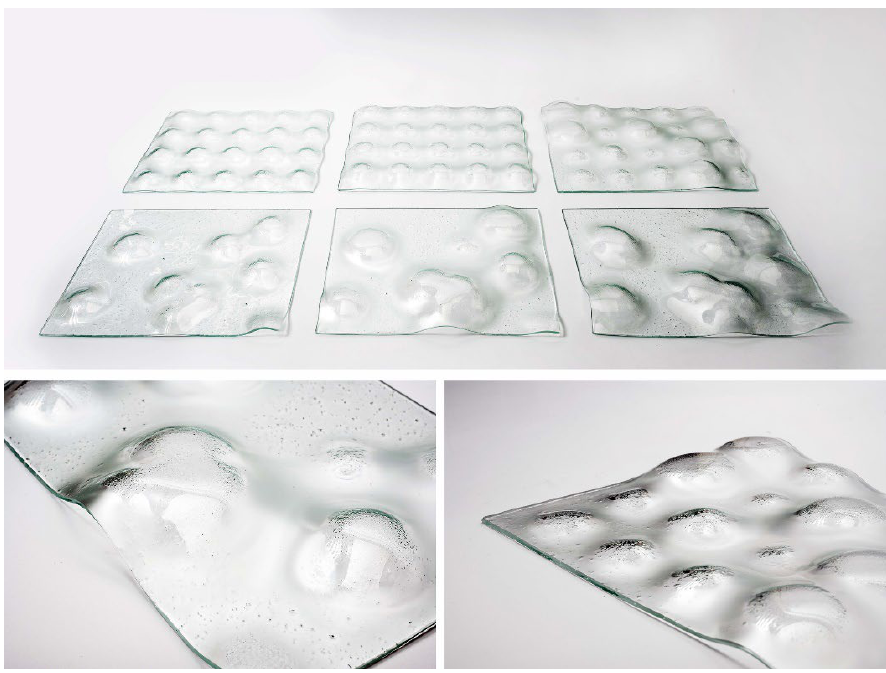
Fig. 8: Doubly curved glass parts (21x33cm size) with varying patterns and heights (top) and light reflections in doubly curved glass parts